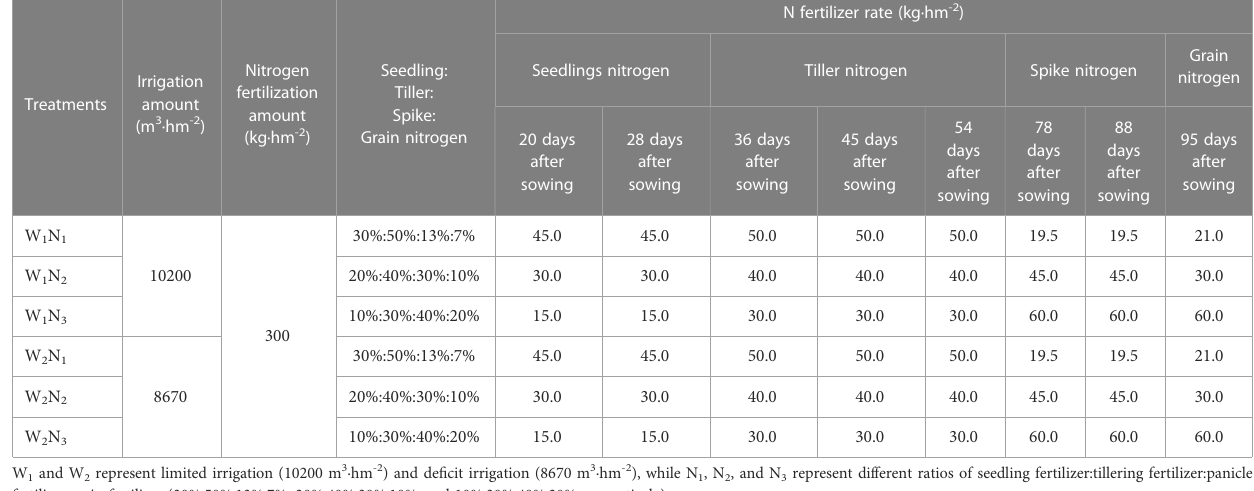
TABLE 1 N rate for drip irrigation rice under plastic fi lm mulching.